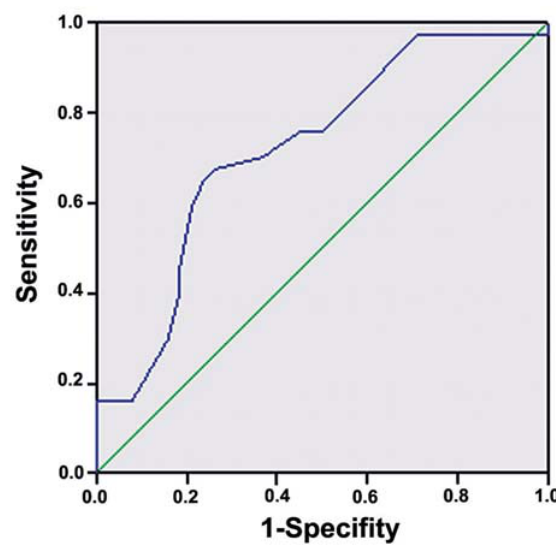
Figure 5 – ROC curve of cut-off points for infundibular height